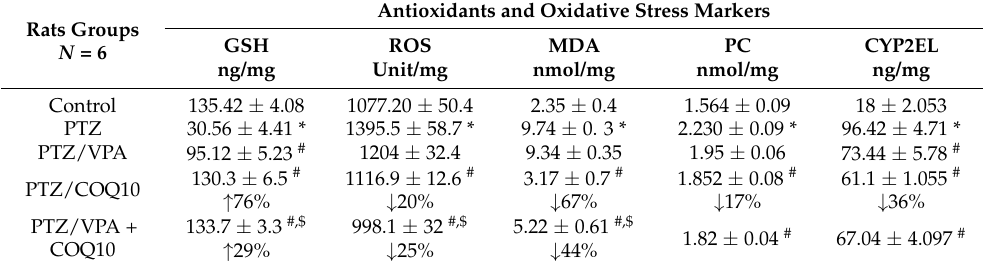
Table 3. Effect of CoQ10 on antioxidants and oxidative stress markers in the hepatic tissue of rats subjected to PTZ